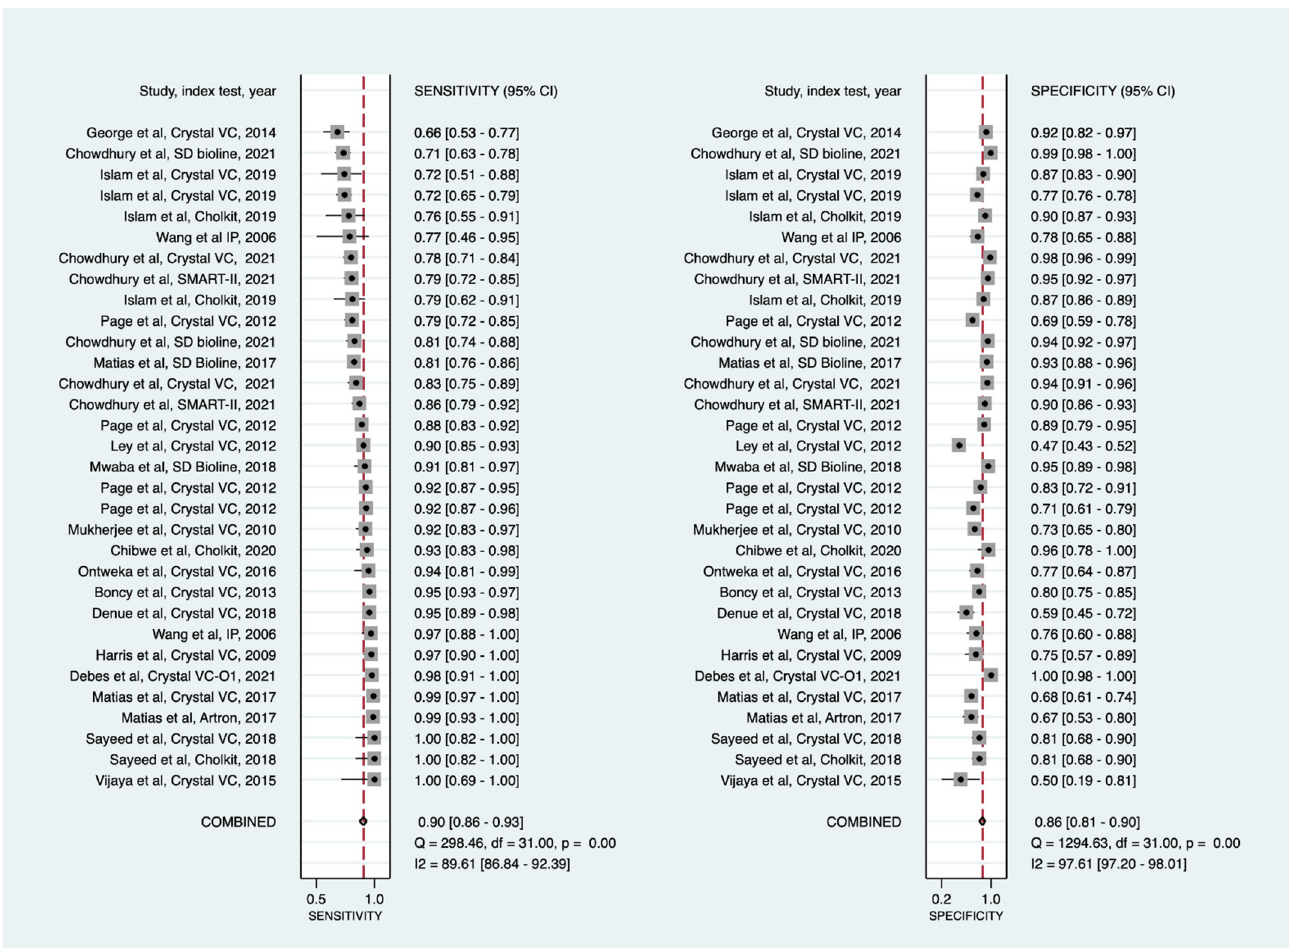
Figure 1. Forest plots of the sensitivities and specificities of cholera rapid diagnostic tests (direct stool testing) for the detection of Vibrio cholerae O1 . CI = confidence interval; IP= Institut Pasteur. Data points are sorted by sensitivity performance.